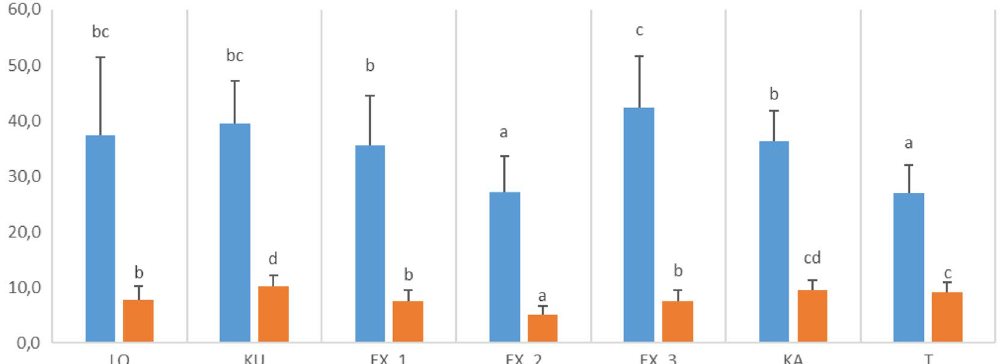
Fig. 2 Statistically significant morphometric variables (biggest leaf length and width) of Plantago maxima among the Hungarian populations under study, detected by Games-Howell post hoc test (p < 0.05). LO – subpopulation 1,2 and 3; KA